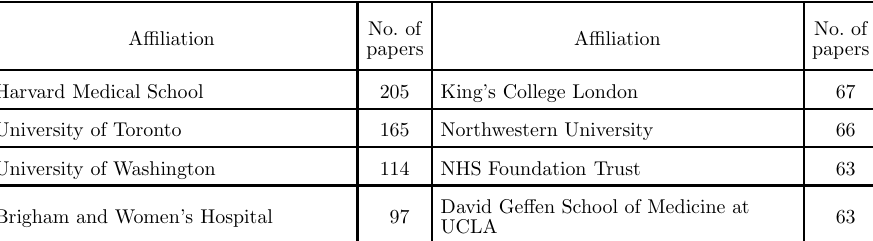
Table 2. List of scientific units/universities issuing publications on the quality of medical services in the Scopus database in 2011–2017 No.